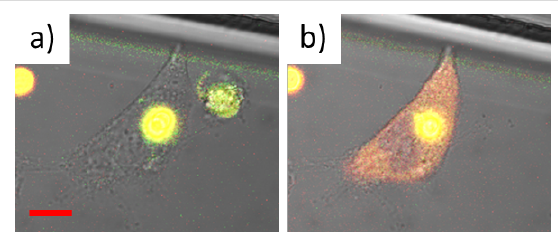
Figure 5: a) A microparticle has been internalized by an A549 lung cancer cell into an intracellular vesicle (here the lysosome [165]) and is thus clearly localized. The microparticle is filled with a pH-sensitive fluorophore (SNARF, from Invitrogen, now LifeTech) linked to dextran and the acidic pH of the lysosome is reported by the yellow fluores- cence. b) After release of the pH-sensitive fluorophore linked to dextran to the cytosol (by photothermal heating), the fluorophore–dextran conjugates are freely dispersed, without any visible granular structure. Due to the neutral pH in the cytosol the fluo- rescence of the fluorophore–dextran conjugates has changed to red. The scale bar corresponds to 10 μ m. Adopted with permission from [166]. Copyright (2012)